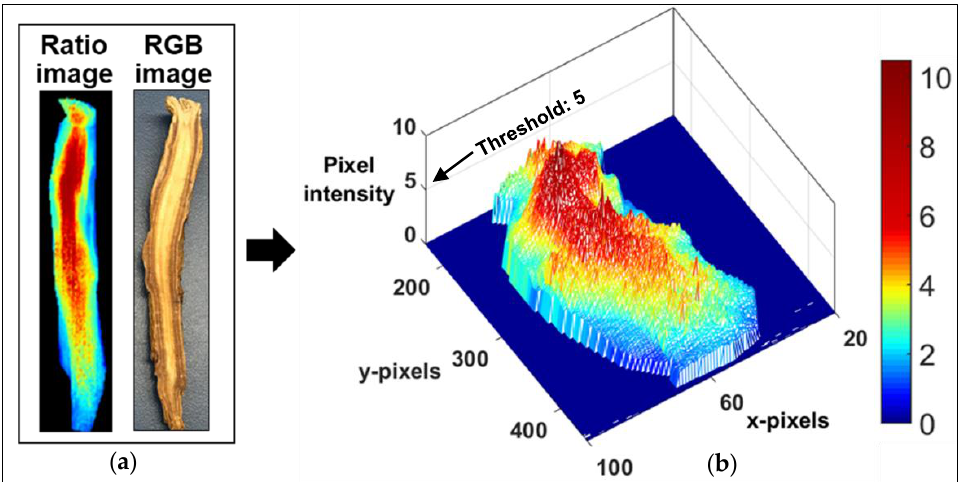
Figure 7. ( a ) Ratio and RGB images of an abnormal ginseng sample used for mash plot development. ( b ) 3D mash plot showing ginseng pixel intensity; the x and y-axis represent the pixel identities, whereas, the z-axis represents the pixel intensity. The red region in the plot belongs to the whitening region. Threshold value of 5 was used to detect the whitening pixels, as the larger proportion of whitening pixels lies above this threshold value.